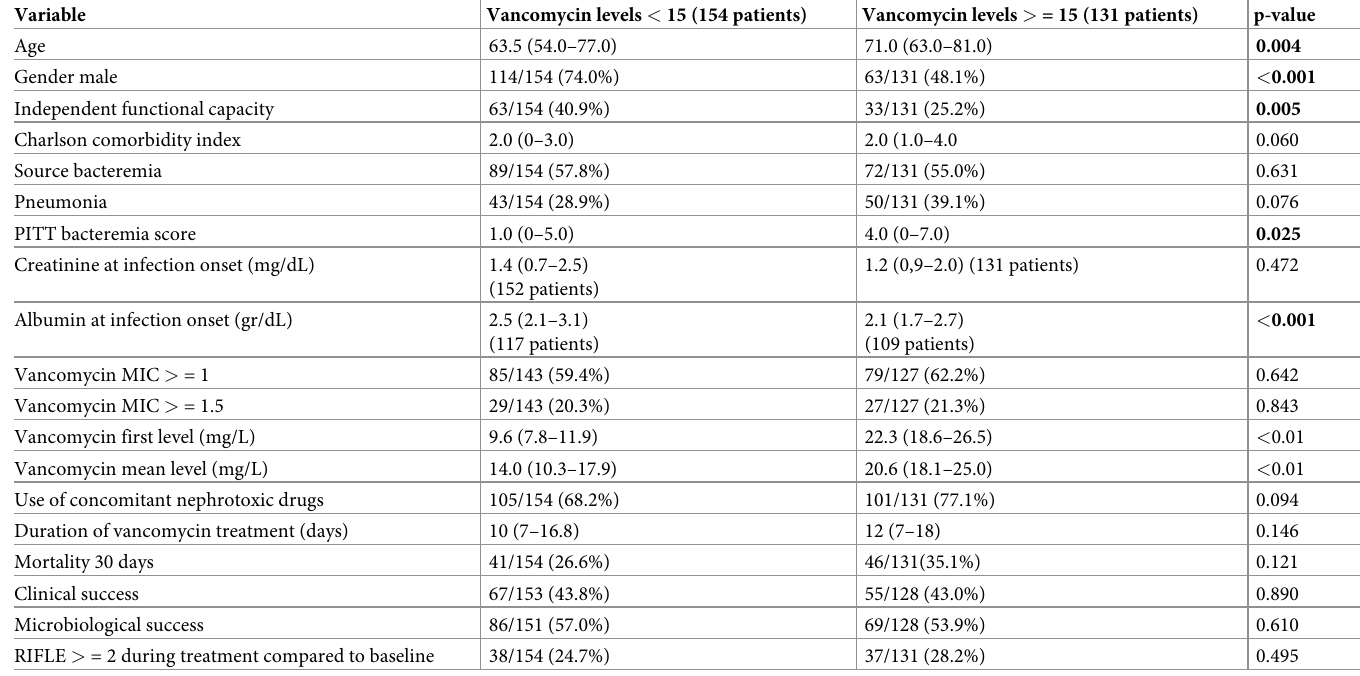
Table 1. Characteristics of patients with low versus high vancomycin levels in the entire cohort.